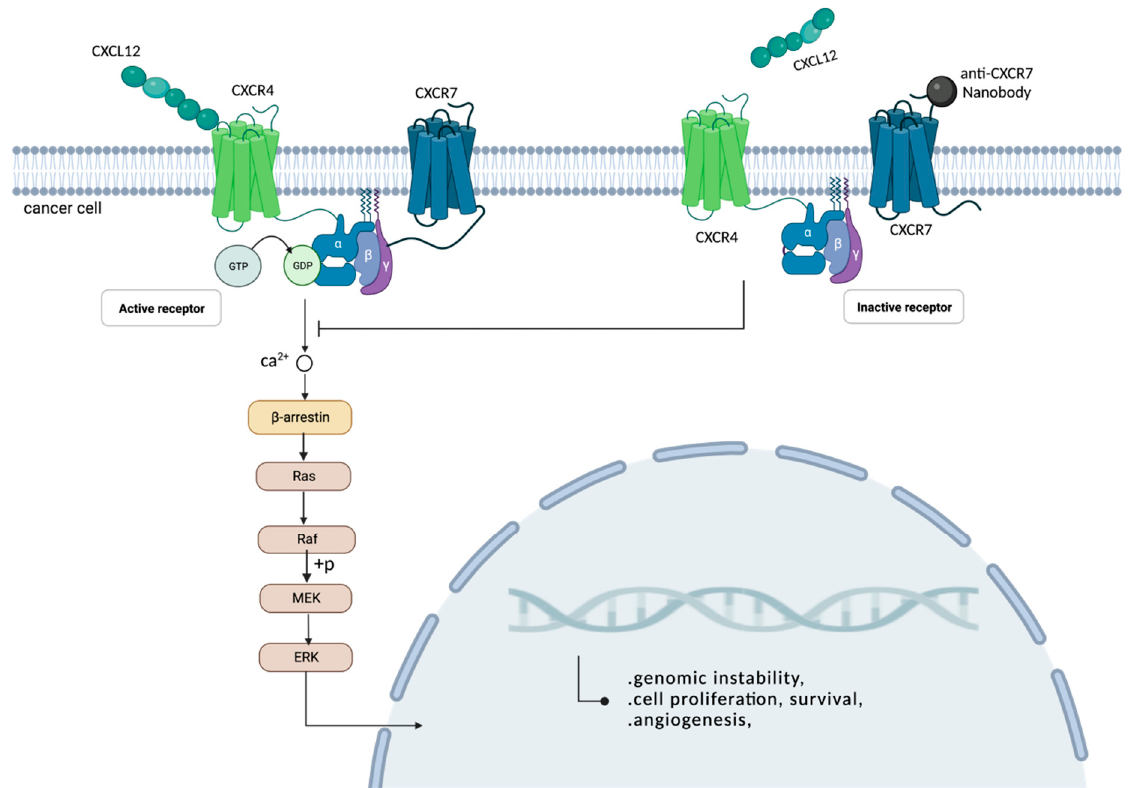
Figure 4. As an extracellular homeostasis chemokine, CXCL12 can bind to receptors CXCR4, forming CXCR4/CXCR7 homodimers, and activate intracellular signaling responses. When anti-CXCR7 nanobodies interact with receptors CXCR7, the binding of CXCL12 to the receptor CXCR4 is blocked, and the G-protein-coupled receptor cannot be activated, thereby inhibiting the intracellular calmodulin response, stopping the recruitment of β -arrestin in the cytoplasm, preventing downstream signaling pathways and inhibiting tumor cell proliferation (This figure was created with BioRender.com, accessed on 8 August 2022).